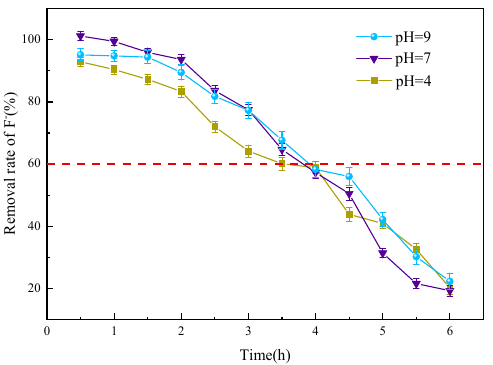
Figure 16. Effect of pH in an adsorbent column. The initial fluoride concentration was set to 1 × 10 − 2 g/L. Flow speed was set to 4 mL/min.